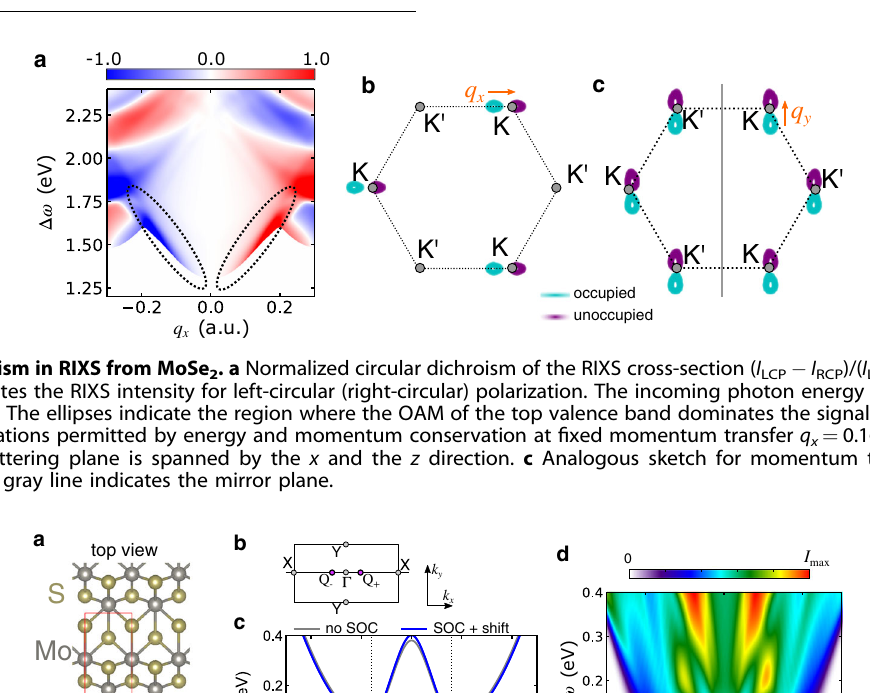
Fig. 4 Electronic structure and RIXS spectrum of 1T 0 -MoS 2 . a Sketch of the lattice structure. The red rectangle indicates the unit cell. b First BZ with important momenta. c Band structure with and without including SOC. Without SOC, there is a pair of Dirac cones at Q ± . d Simulated polarization-averaged RIXS intensity at temperature T = 20 K. The scattering angle is fi xed at 2 θ = 130 ∘